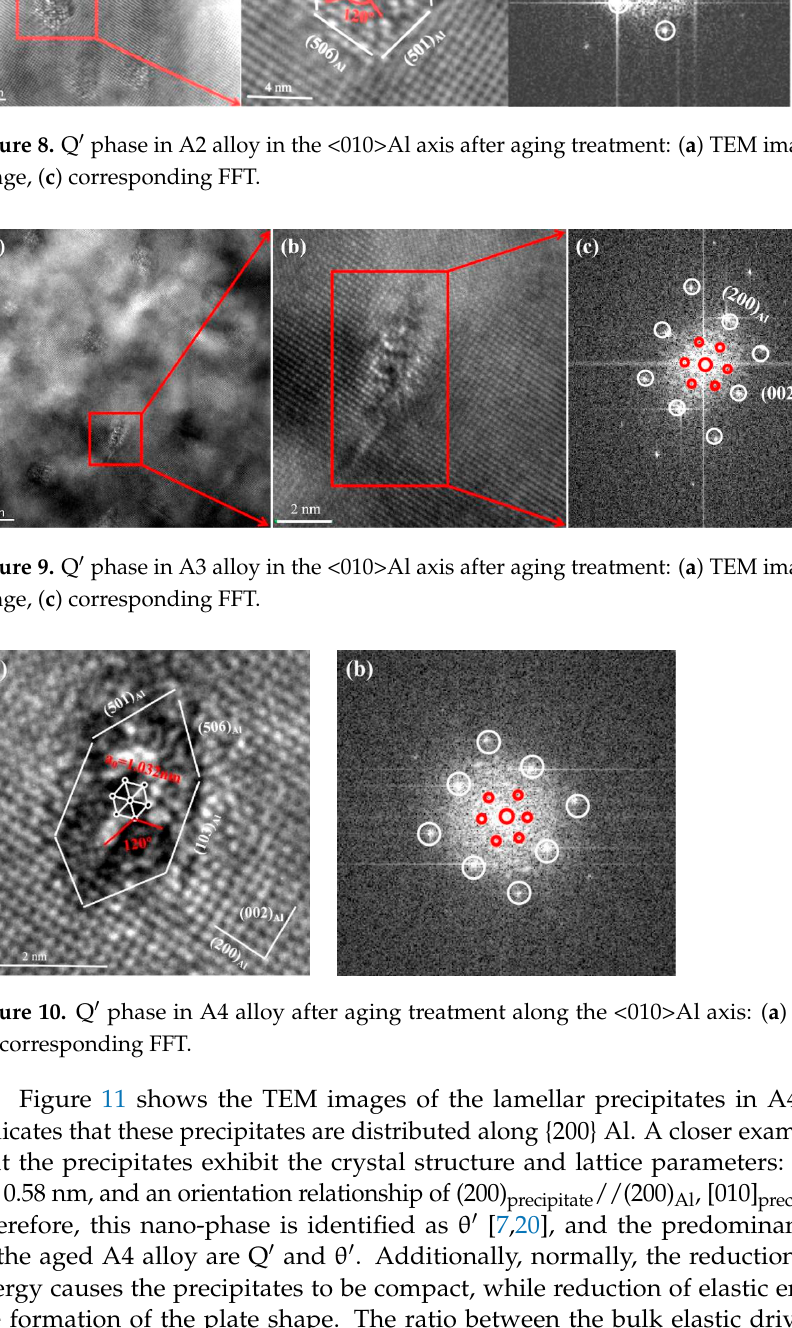
Figure 8. Q ′ phase in A2 alloy in the <010>Al axis after aging treatment: ( a ) TEM image, ( b ) HRTEM image, ( c ) corresponding FFT.